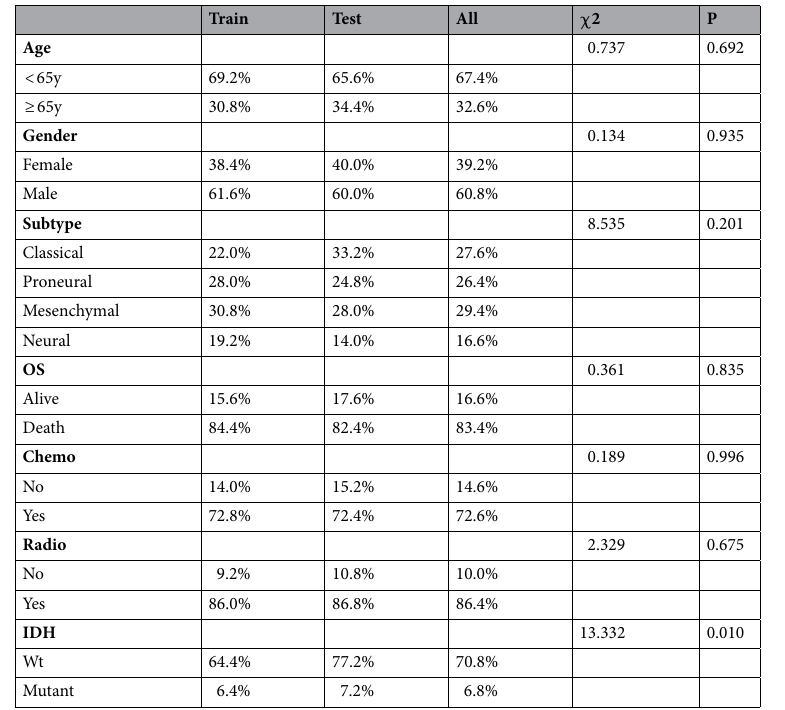
Table 1. Clinicopathological variables of GBM patients in TCGA